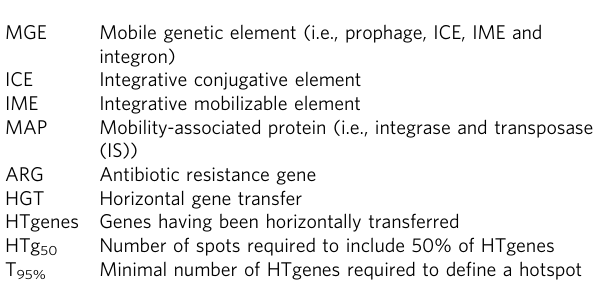
Fig. 2 Cumulative frequency of HTgenes. a Cumulative distribution of horizontally transferred genes (HTgenes, %) in spots for the 80 bacterial clades. b Histogram of the minimum number of spots needed to attain 50% of the total number of HTgenes (HTg 50 index). The average HTg 50 was only 1.9% ( ± 0.2;